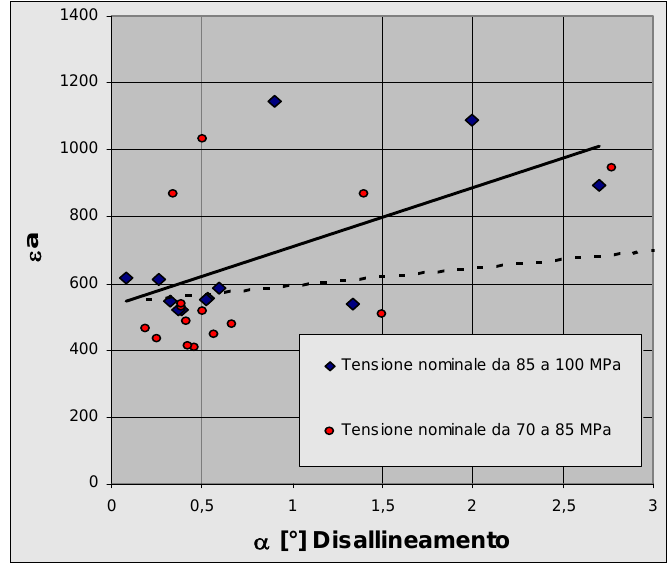
Figura 6: Correlazione tra l’ampiezza di deformazione locale  a e l’angolo di disallineamento  .